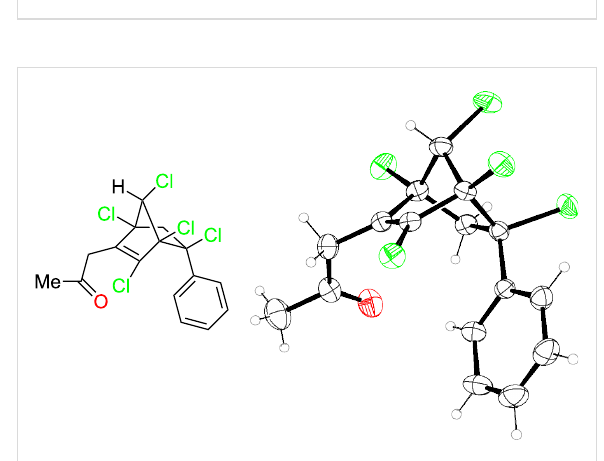
Figure 2: X-ray crystal structure of 8a with 30% thermal